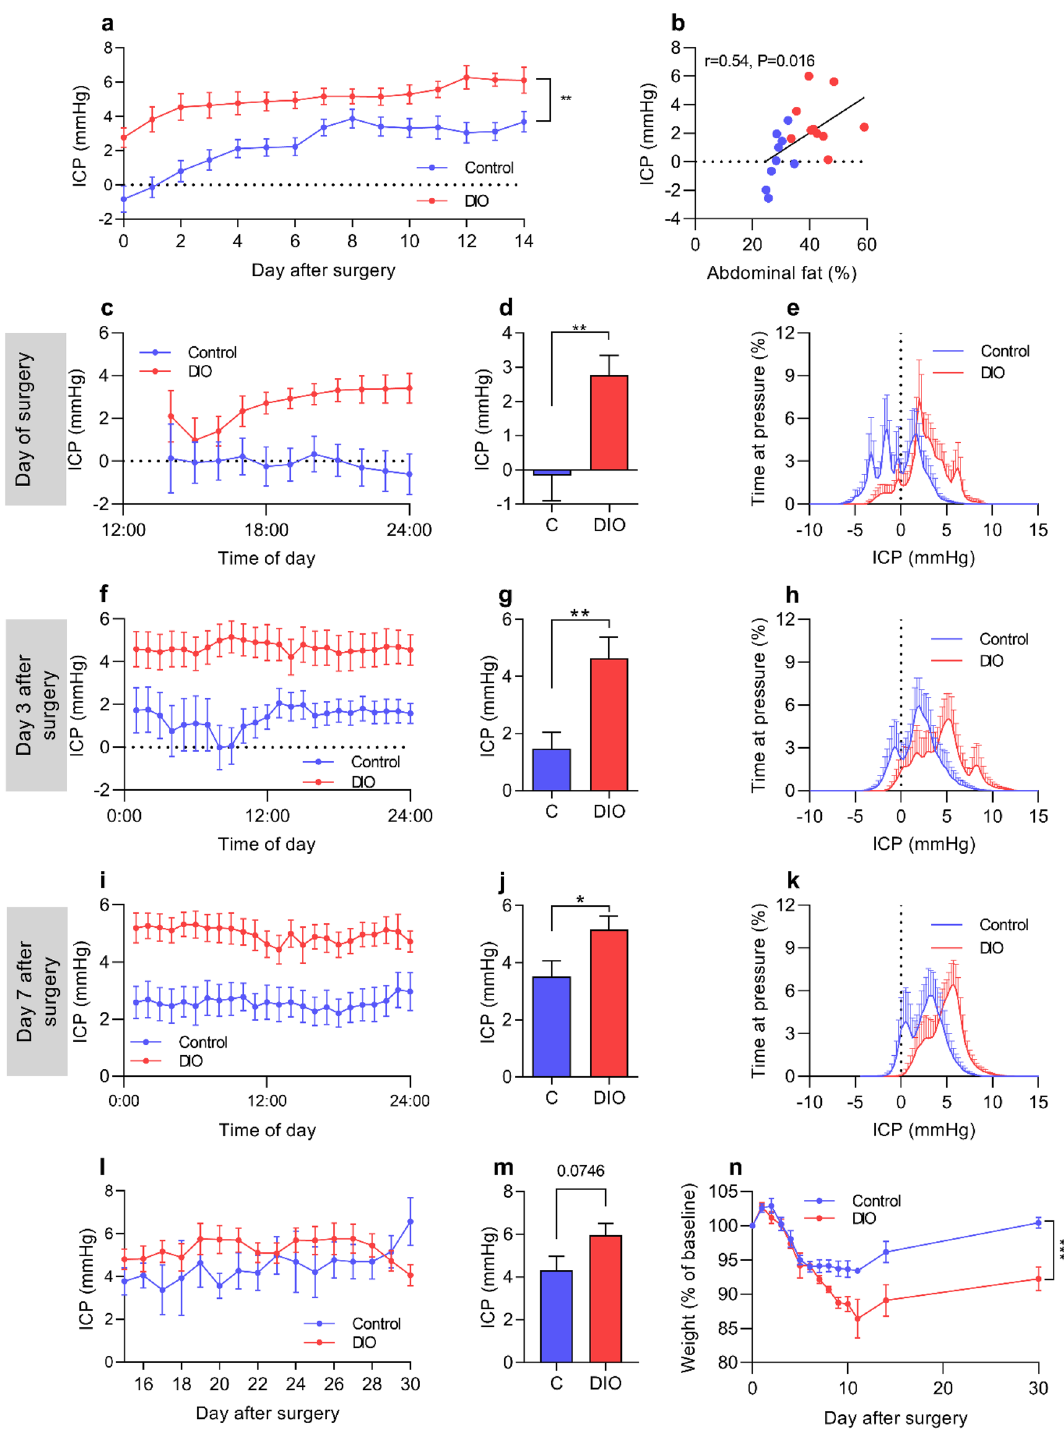
Figure 1. DIO increases ICP in female rats. Female Sprague–Dawley rats on control and high fat diet implanted with ICP probes for 30 days. ( a ) ICP pressure trace over the 14 day ICP monitoring period. ( b ) Scatter graph depicting abdominal fat % vs ICP on day 0. ( c ) ICP pressure trace on day 0. ( d ) Mean ICP on the day of surgery. ( e ) Pressure frequency histogram from day of surgery. ( f ) ICP pressure trace on day 3. ( g ) Mean ICP on day 3. ( h ) Pressure frequency histogram from day 3 ( i ) ICP pressure trace on day 7. ( j ) Mean ICP on day 7. ( k ) Pressure frequency histogram from day 7. ( l ) ICP trace from day 15 to 30, note that multiple data points are missing. ( m ) Mean ICP over the final 7 days of ICP recording. ( n ) Weight loss and regain following surgery. Data points in ( a,l,n ) represent daily means, whereas data points in ( c,f,i ) represent hourly means. Control N = 9, DIO N = 10. Two-way repeated measures ANOVA for ( a,l ) and Mixed effects analysis for ( n ). Pearson’s correlation for ( b ) and unpaired students T-tests for ( d,g,j,m ). *P < 0.05, **P < 0.01. Data presented as mean ±